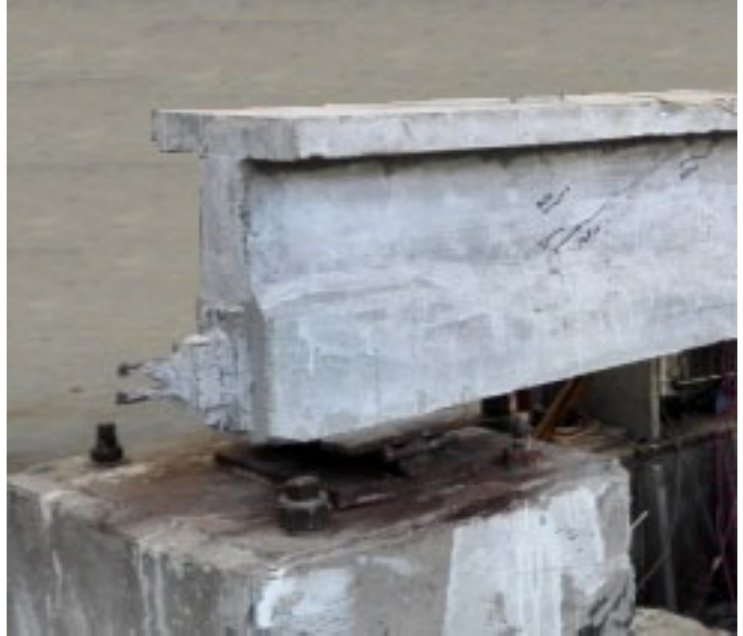
Table 2. Material properties of reinforcement. Figure 2. Anchor end of the model Figure 2. Anchor end of the model beam. Table 1. Mixture ratio and type of concrete.